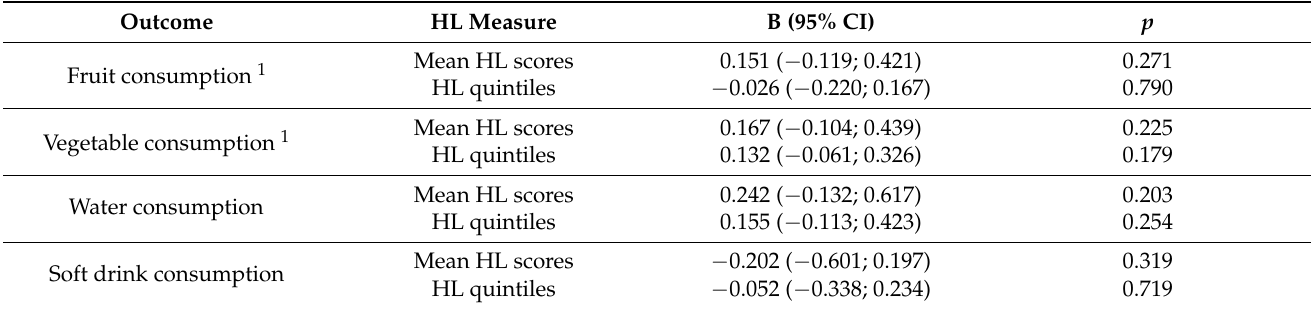
Table 4. Relationship between children’s HL and fruit, vegetable, water, and soft drink